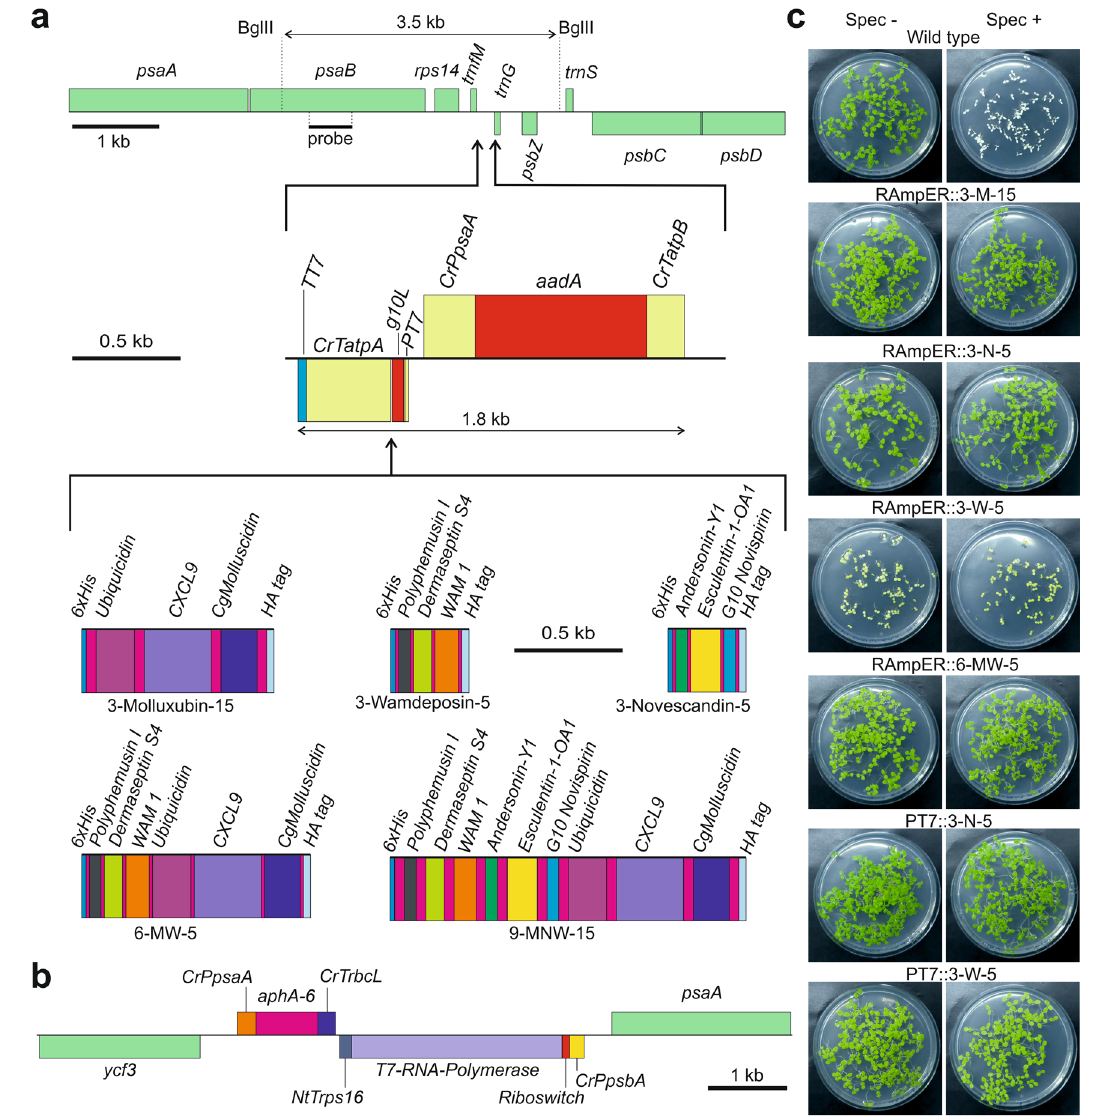
Fig.3|ApplicationoftheRAmpERsystemtocontrolexpressionoffAMPsfrom the tobacco plastid genome. a Construct design (cf. Fig. 1a). The fAMP-encoding sequenceswereinserted betweenthe T7promoter( PT7 )withthe T7 gene10 leader ( g10L ) and the C. reinhardtii atpA 3 ′ UTR ( CrTatpA ) followed by the T7 gene10 3 ′ UTR ( TT7 ). For information on the fAMP combinations and the linkers (of 5 or 15 aminoacids;pink),seeSupplementaryTable1andSupplementaryData2.Notethat the constructs driven by PT7 have the opposite orientation in the plastid genome compared to the constitutive constructs (Fig. 1), to reduce potential read-through transcription from upstream plastid genes. b Physical map of the region in the plastid genome of the transplastomic recipient line Nt-DK320 that harbors the riboswitch-controlled T7 RNA polymerase gene targeted to the intergenic spacer between ycf3 and psaA by selection for kanamycin resistance provided by a chi- meric aphA-6 gene controlled by the C. reinhardtii psaA promoter ( CrPpsaA )